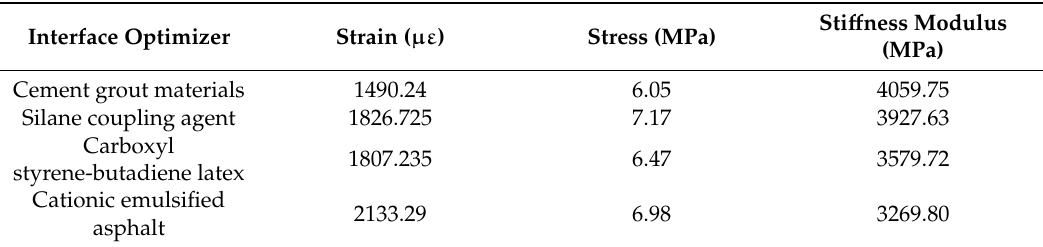
Table 11. Low-temperature bending test results.